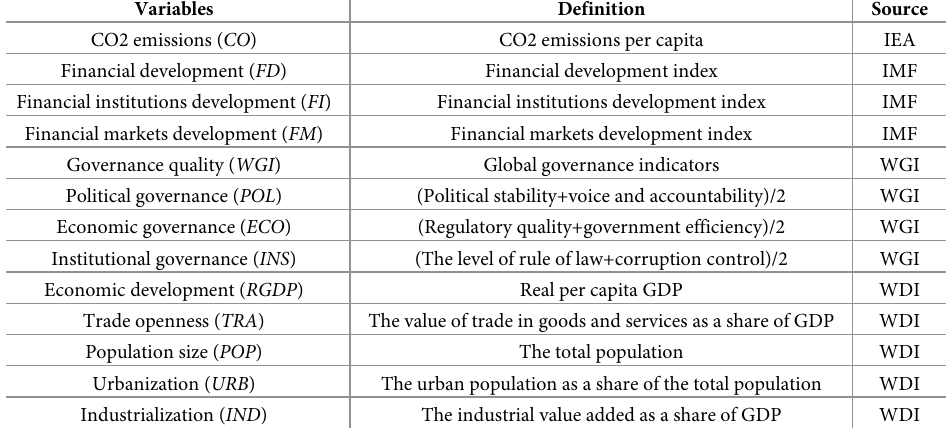
Table 1. Definition and source of the used